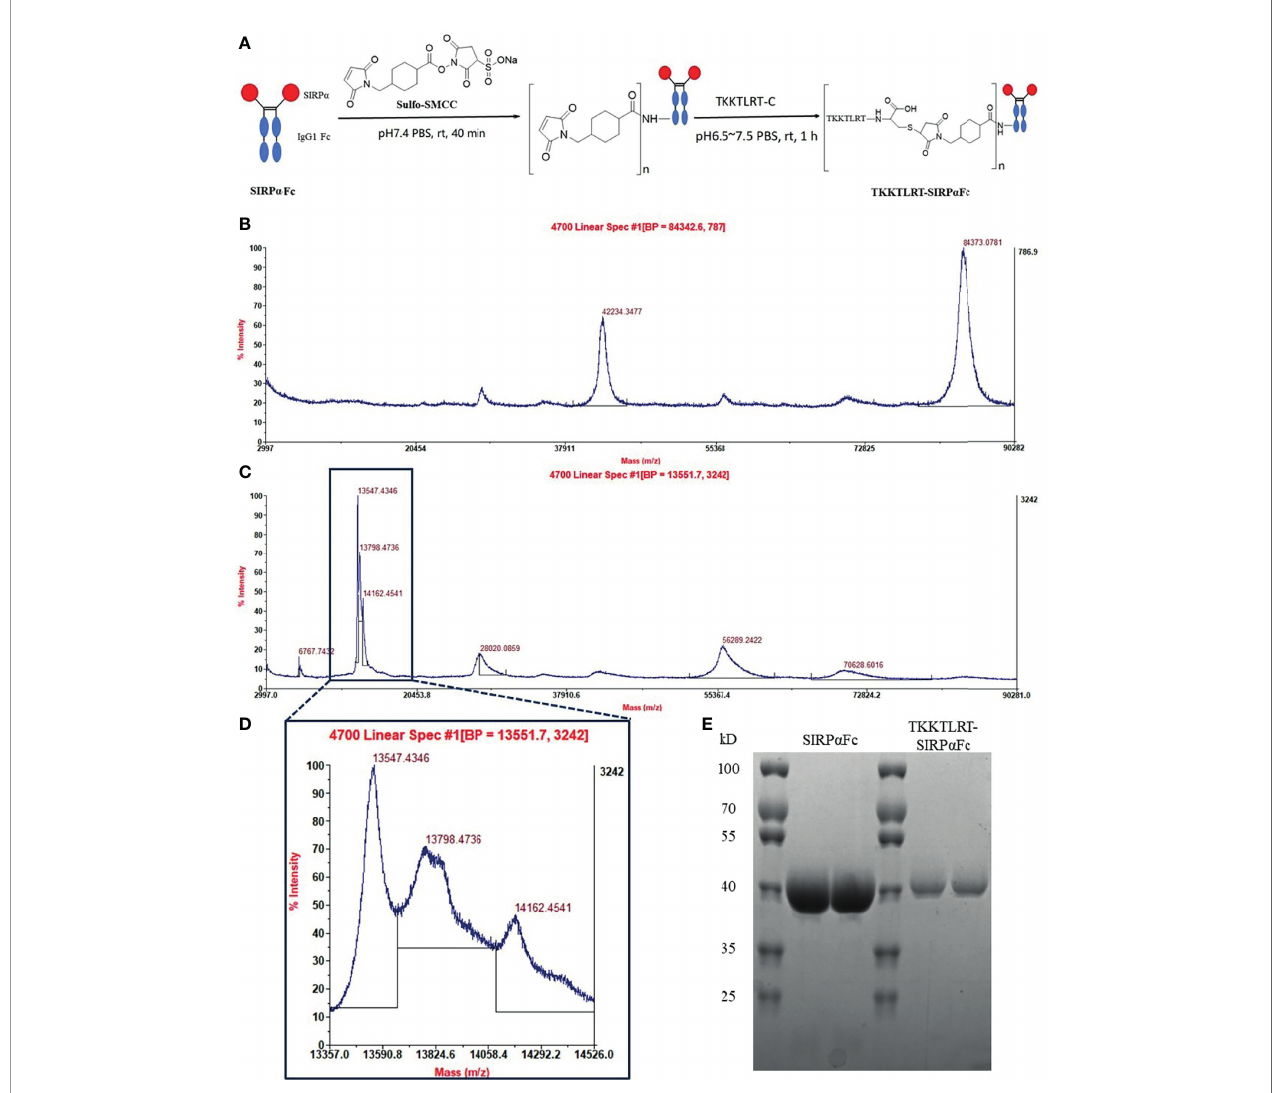
FIGURE 1 | CBD – SIRP a Fc conjugate was synthesized and identi fi ed. (A) Polypeptide “ TKKTLRT ” conjugates to human SIRP a Fc fusion protein with its designed cysteine terminal and a linker Sulfo-SMCC through a two-step reaction. (B) The exact molecular weight of SIRP a Fc was detected in MALDI-TOF-MS. SIRP a Fc weighted 84,373 D and tended to be ionized with two charges, which represented a half mass-to-charge ratio weighting about 42,234 D (data representative of 2 replicates). (C) CBD – SIRP a Fc was ionized into multiple-charged ions with three (m-z ratio about 28,000), six (m-z ratio about 14,000), or twelve (m-z ratio about 7,000) charges, while some molecules may share charges and represented a non-integral mass-to-charge ratio such as two-thirds (about 56,000) and fi ve-sixths (about 70,000) of the single charge ion (data representative of 2 replicates). (D) The main peak (m-z ratio about 14,000) in the CBD – SIRP a Fc spectrogram was divided into three sub-peaks. There was a difference of about one-sixth of the total weight of one molecule of Sulfo-SMCC and one molecule of polypeptide “ TKKTLRTC ” (about 300 D) between each sub-peaks, indicating that one or two molecules of the CBD polypeptide had conjugated to one molecule of SIRP a Fc. (E) Protein bands were shown in reductive SDS-PAGE (two replicates). SIRP a Fc was just below 40 kD. CBD – SIRP a Fc showed a simple band at 40 kD above the SIRP a Fc